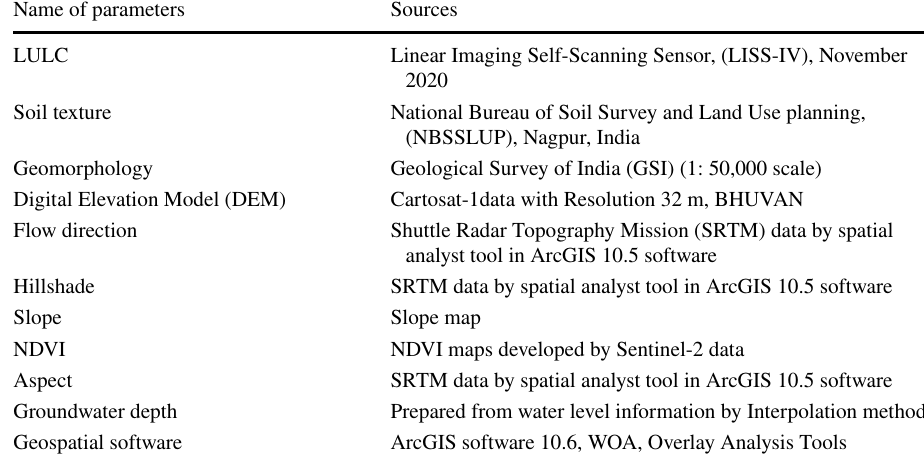
Table 2 Selected parameters and related